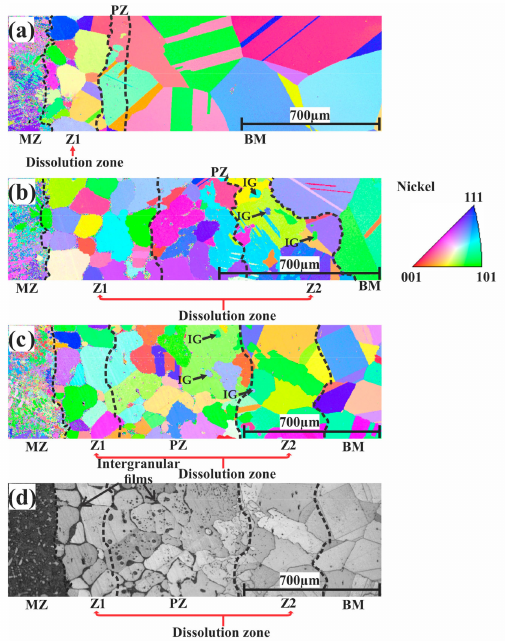
Figure 16. ACOM (automatic crystal orientation mapping) mapping of some wedge-samples: ( a ) Sol-Wasp, ( b ) Ni-Sol-Wasp and ( c ) Ni-Age-Wasp, and ( d ) Micrograph of